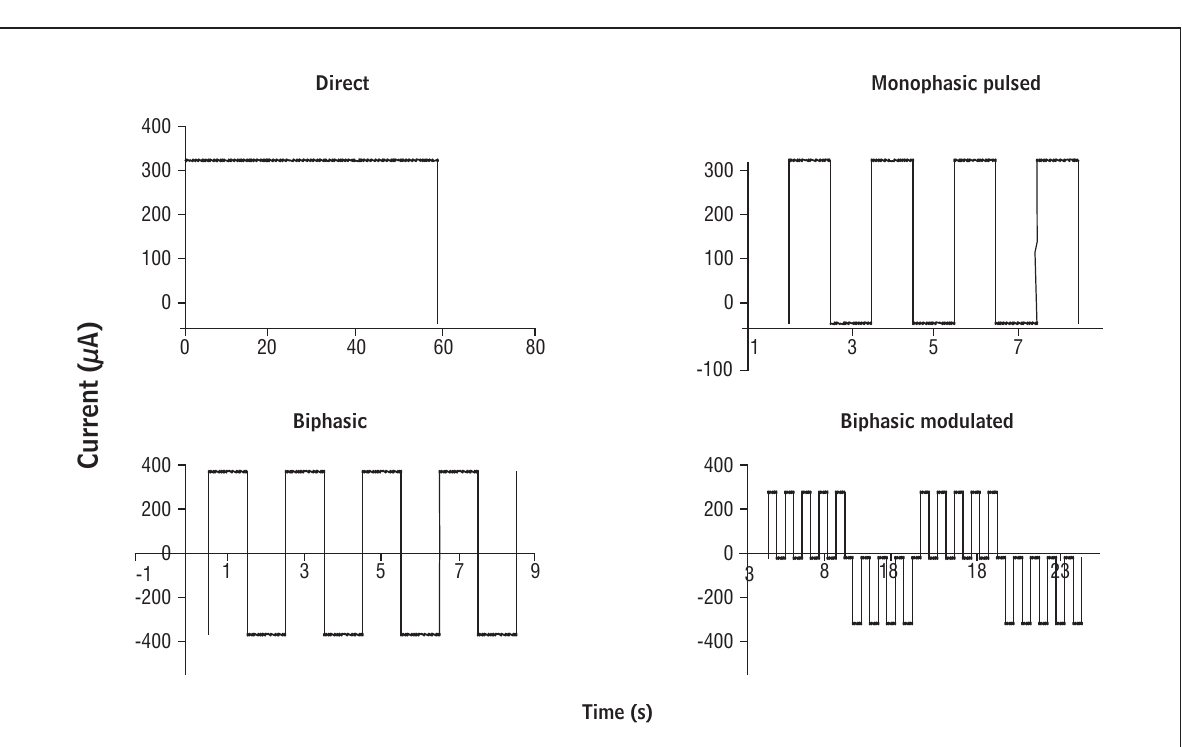
Figure 2 - Types of quadratic waveform used in iontophoresis Source: Modi fi ed from Ching et al.